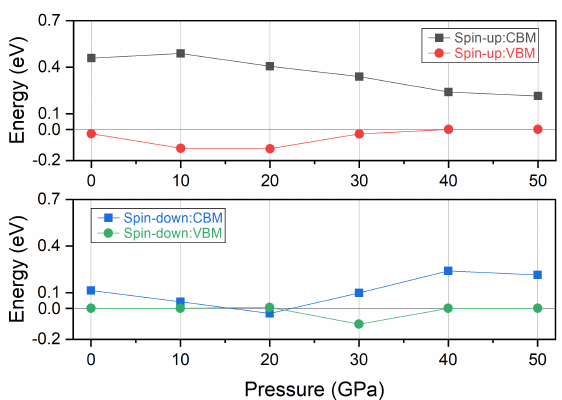
Figure 4. The valence band maximum (VBM) and conduction band minimum (CBM) of Ti 2 MnAl compound in the spin-up and spin-down channels under different